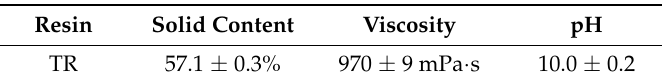
Table 1. The physical properties of